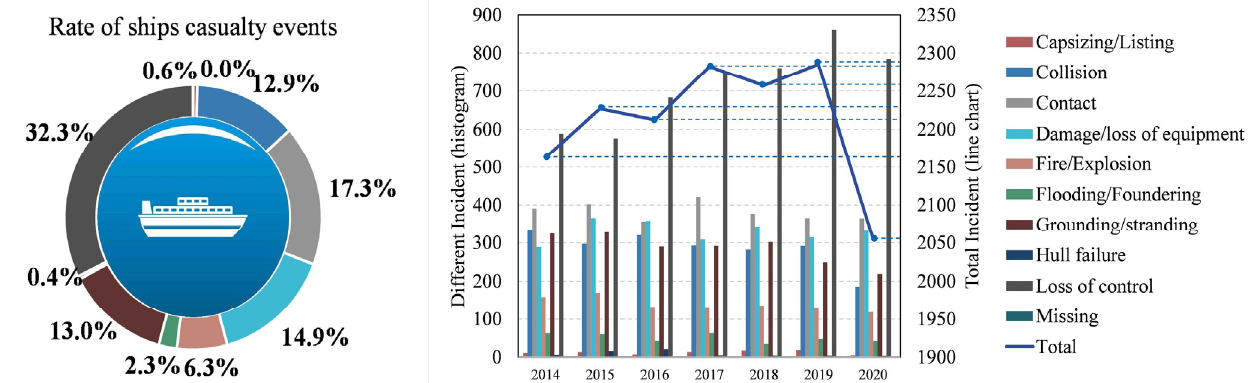
Figure 1. Distribution of casualty events with a ship.